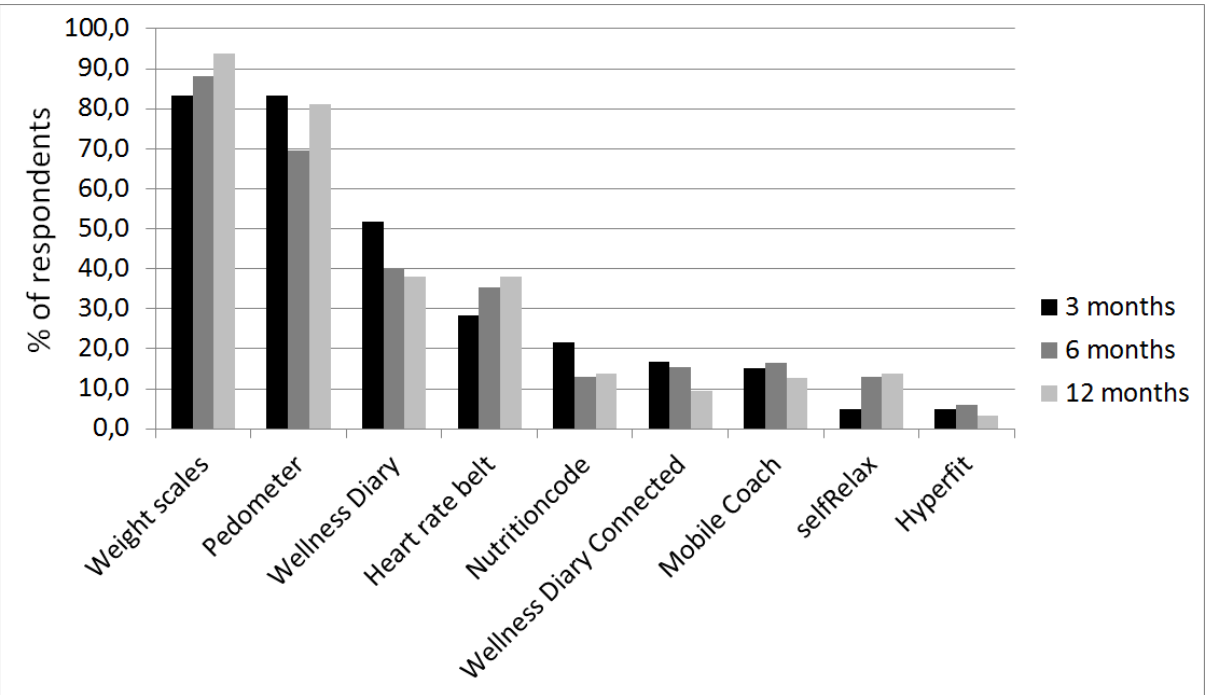
Figure 4. Best technologies for supporting wellness management based on responses to the 3-month, 6-month, and 12-month questionnaires. The bars represent the percentage of respondents choosing the technology among the top 3 best